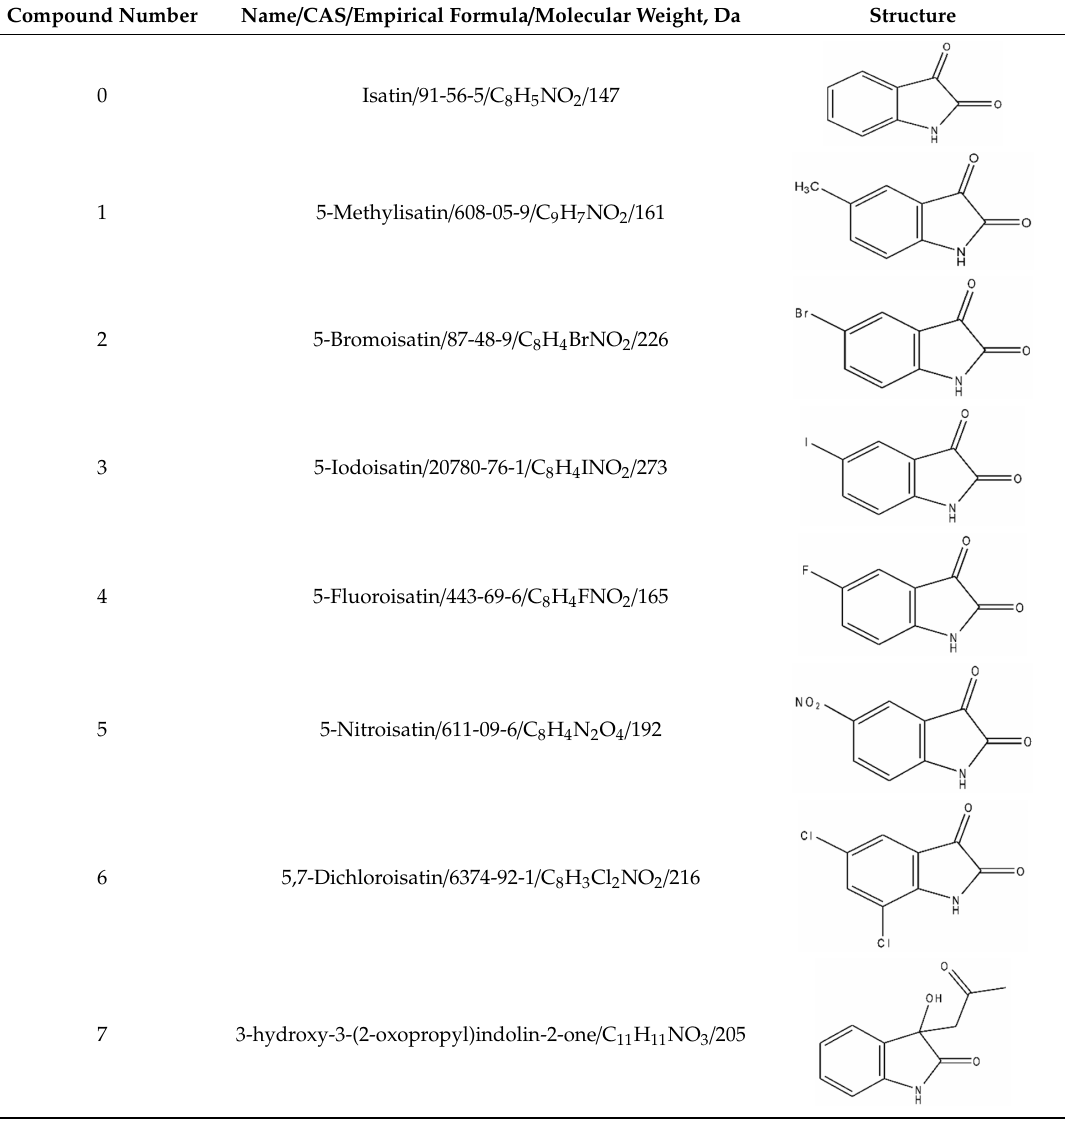
Table 1. The list of isatin derivatives which were used for the SPR